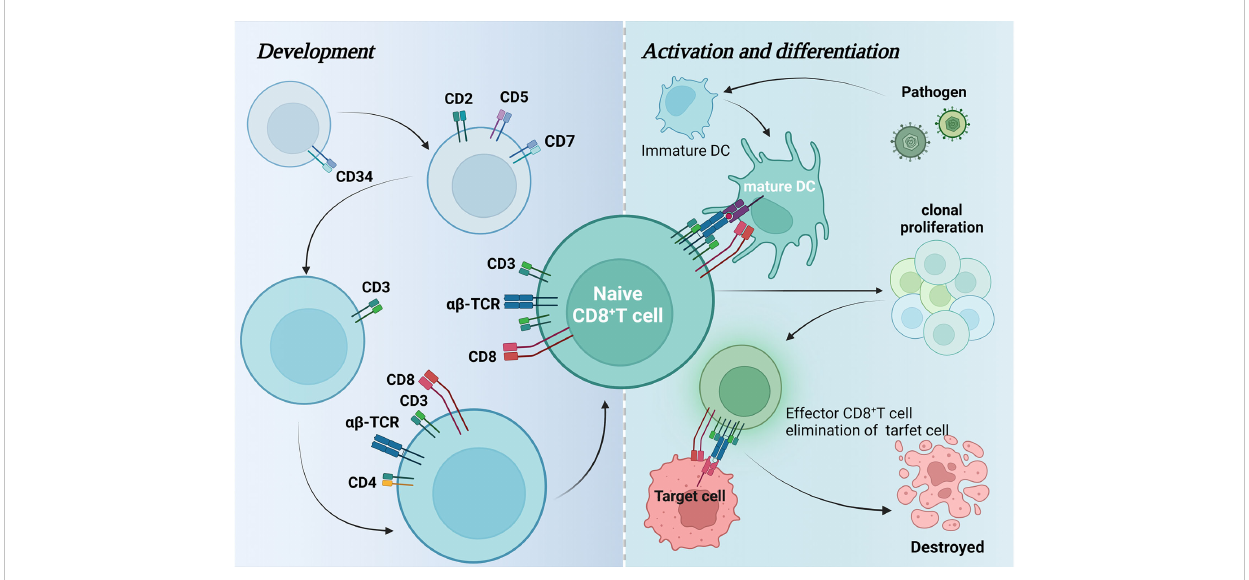
FIGURE 1 Development, activation, and differentiation of CD8 + T cells. This fi gure maps the changes in surface-speci fi c antigens during CD8 + T cell development and how they are activated by dendritic cells to differentiate and generate effector CD8 + T cells that attack pathogenic target cells and eventually cause them to